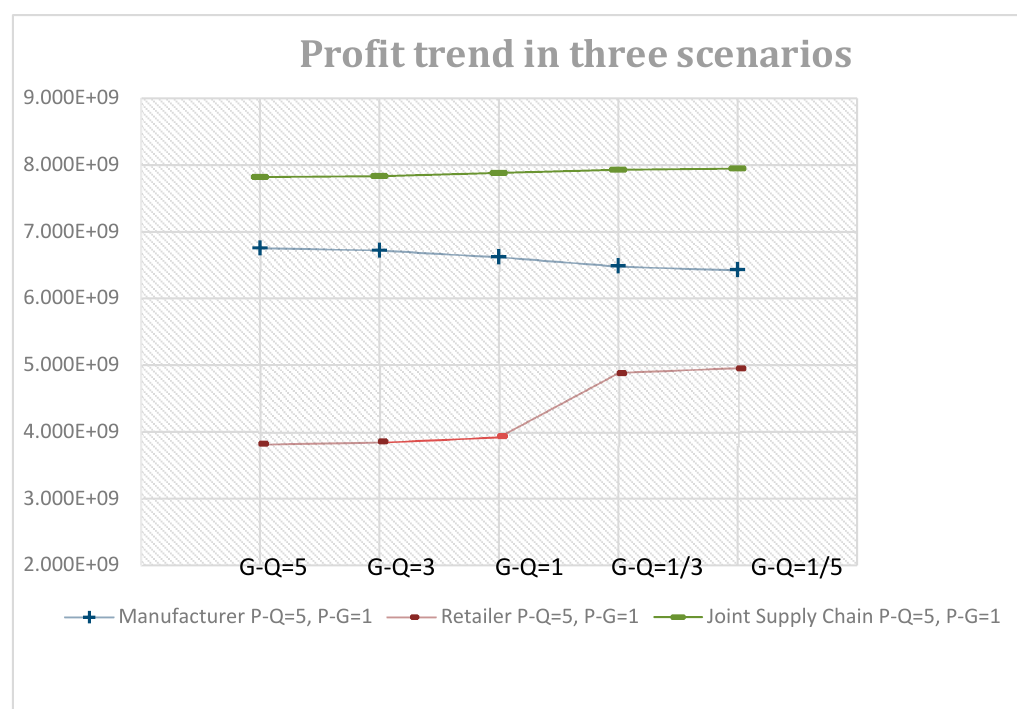
Figure 9. Profit trend of manufacturer, retailer, and joint supply chain when P-Q=5, P-G=1.